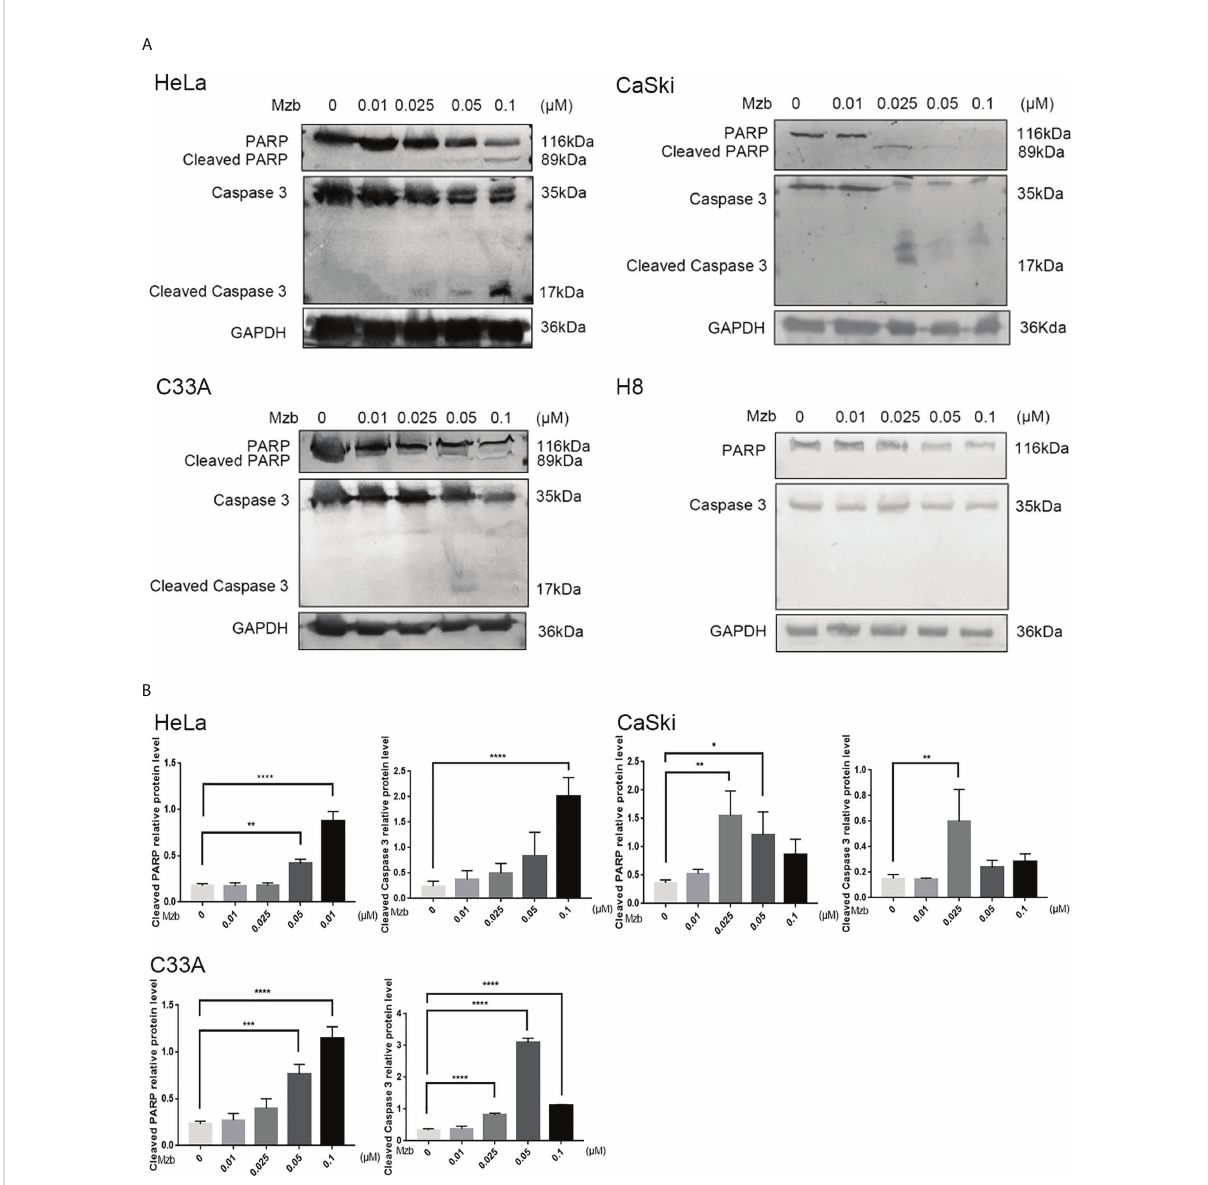
FIGURE 2 Marizomib induces apoptosis in cervical cancer cells. (A, B) The cervical cancer cell lines HeLa, CaSki, and C33A and cervical epithelial immortalized H8 cells were treated with marizomib (0, 0.01 m M, 0.025 m M, 0.05 m M, or 0.1 m M) for 16 h or 24 h. Then, whole-cell lysates were subjected to SDS − PAGE and immunoblotted with antibodies against PARP and caspase 3 to detect apoptosis. GAPDH was used as the loading control. *P<0.05, **P ≤ 0.01, ***P ≤ 0.001, ****P ≤ 0.0001, by ANOVA (Dunnett ’ s multiple comparison